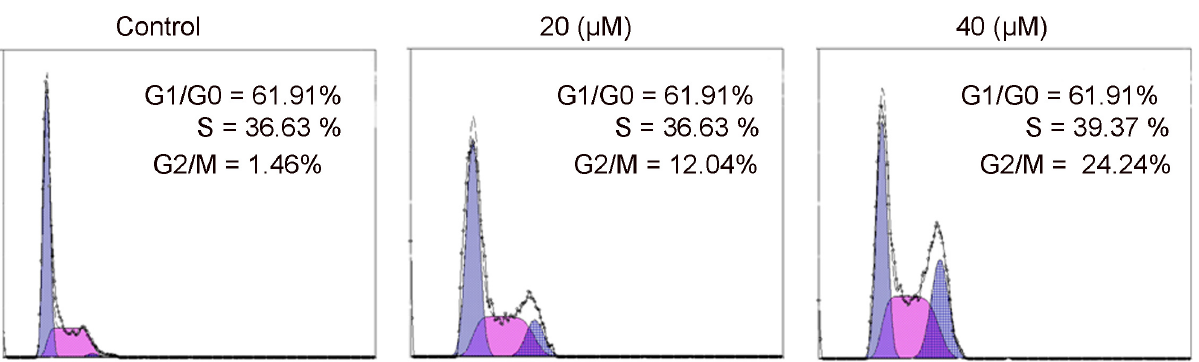
Figure 4. Flow cytometry analysis of cell cycle phase distribution in PC3 cells treated with 20 and 40 µM isoalantolactone for 24 h. Data are expressed as mean ±SD (n = 3). Columns not sharing the same superscript letter differ significantly ( p <